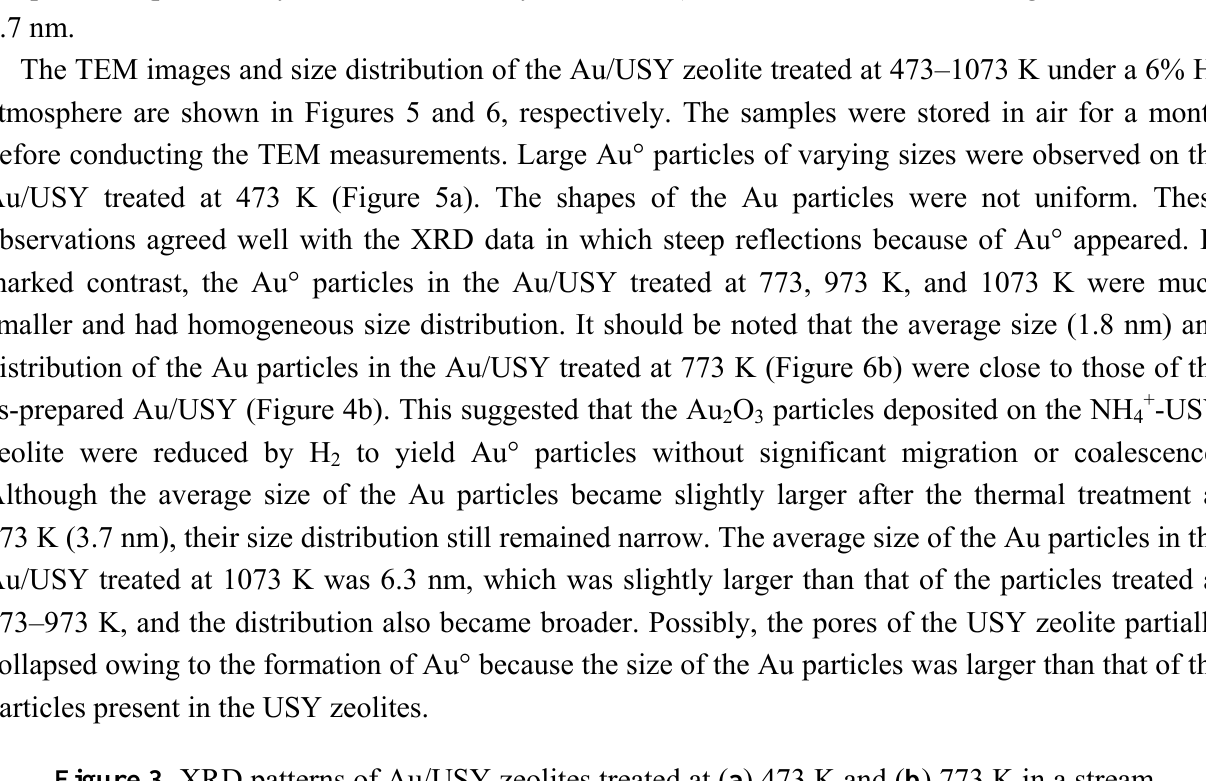
Figure 3. XRD patterns of Au/USY zeolites treated at ( a ) 473 K and ( b ) 773 K in a stream , followed by storage under atmospheric conditions at room of 6% H 2